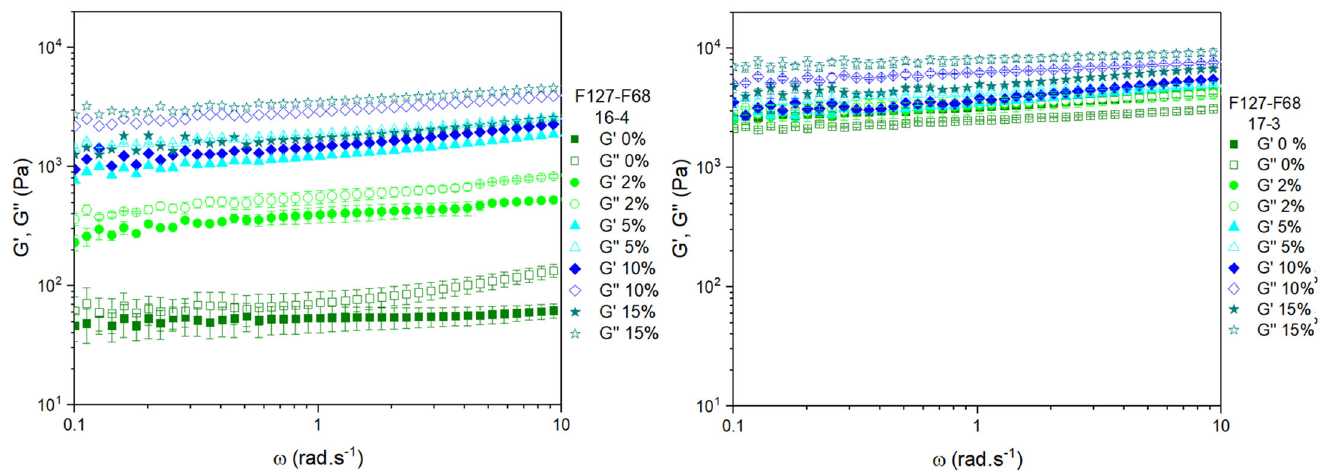
Figure 5. Frequency sweeps of the microparticle–Pluronic hydrogel composite system with different microparticle concentrations (wt.%) at 37 ◦ C. On the ( left ), a Pluronic ratio of 16:4 and on the ( right ) of 17:3.